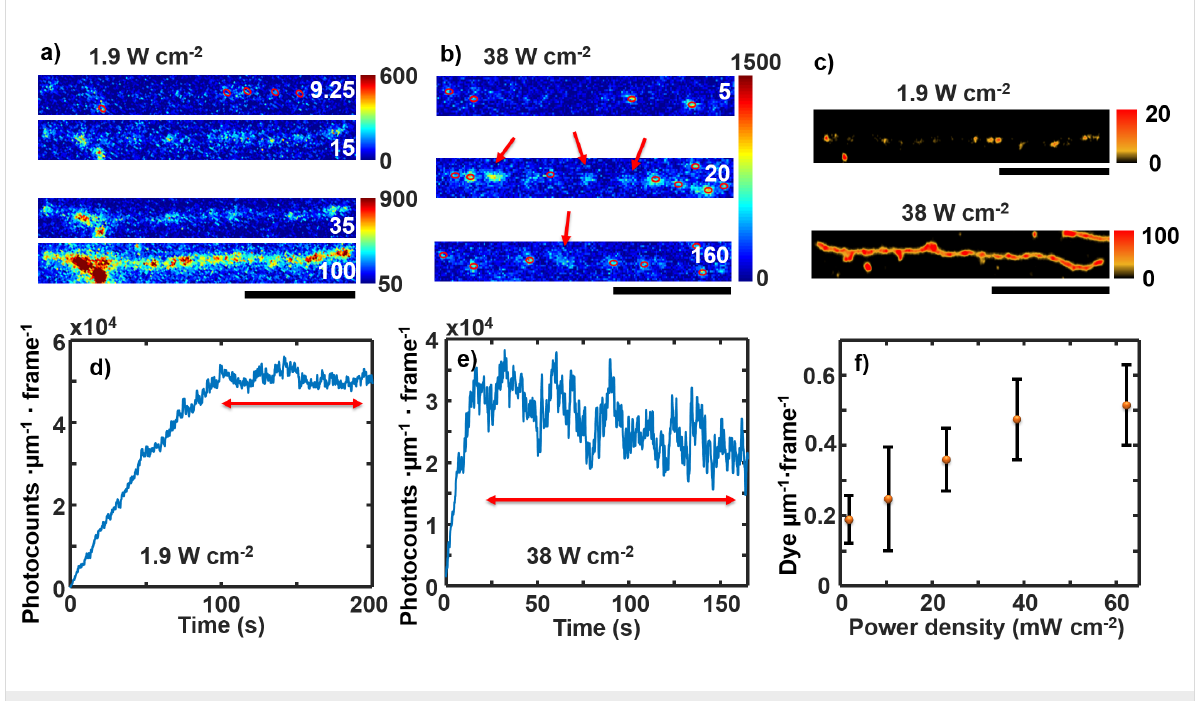
Figure 8: Single-frame images of a single DNA molecule at (a) 1.9 W cm − 2 and (b) 38 W cm − 2 power densities (time shown is in unit of seconds) and (c) corresponding PAINT images. Red circles show events selected and arrows show the events discarded by the code and bleached later. All scale bars are 5 μ m. (d, e) Normalized total photocounts of 1 μ m of DNA in each frame at 1.9 W cm − 2 and 38 W cm − 2 power densities, respectively. The red double arrows indicate where equilibrium is maintained. (f) The average number of dye molecules selected in the frames during the PAINT analy- sis. The error bars represent the standard deviation between ≈ 20 DNA for two samples.